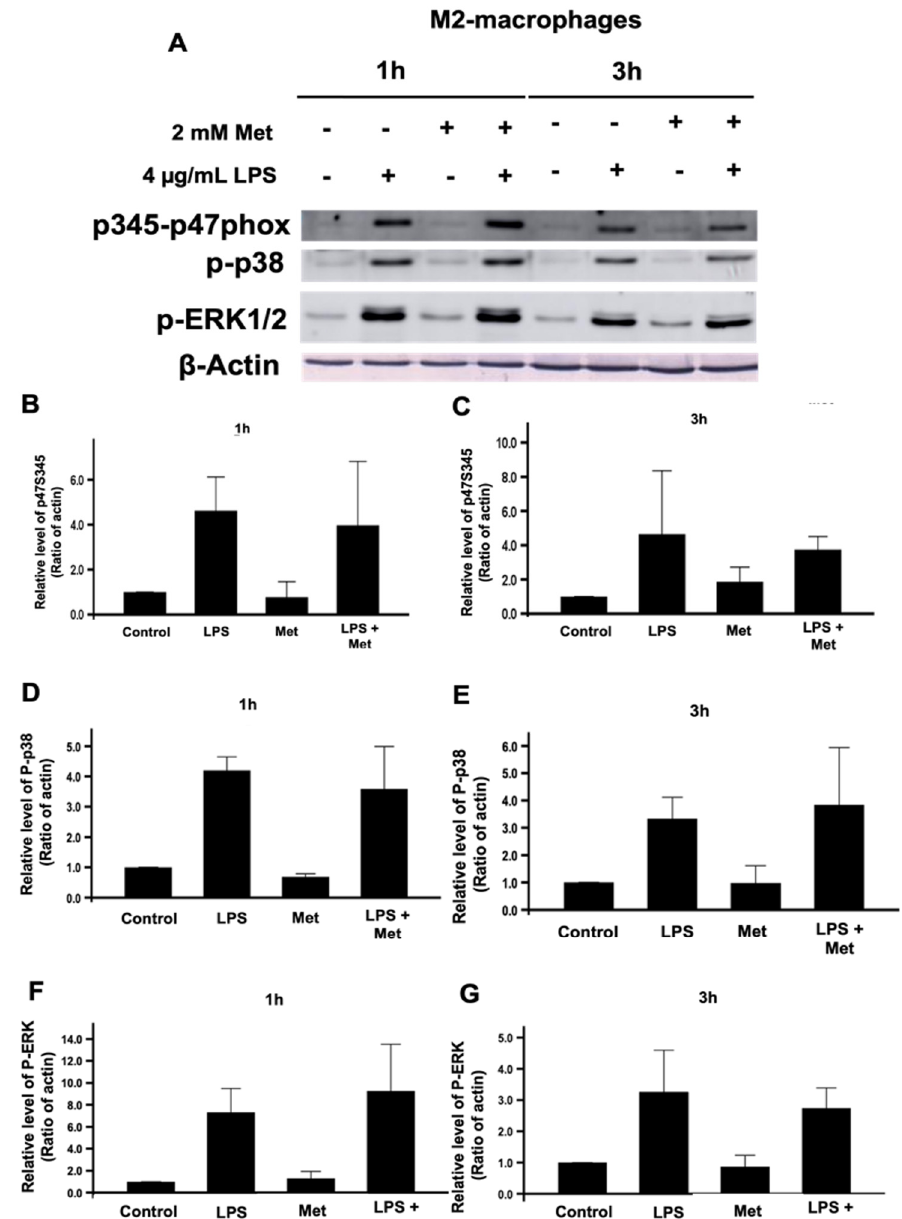
Figure 5. Effect of metformin on the phosphorylation of Ser345 of p47phox and its upstream MAP kinases, p38MAPK, and ERK1/2 in M2 macrophages. M2 macrophages were incubated in the absence or the presence of 2 mM metformin, then stimulated by LPS (4 µg/mL) for 1 and 3 h. The phosphorylation of Ser345-p47phox, p38MAPK, and ERK1/2 was evaluated compared to actin by SDS-PAGE and Western blot using specific antibodies ( A ). The pSer345-p47phox ( B , C ), p38MAPK ( D , E ), and ERK1/2 ( F , G ) and actin bands from three experiments were quantified and expressed as mean ± SD .